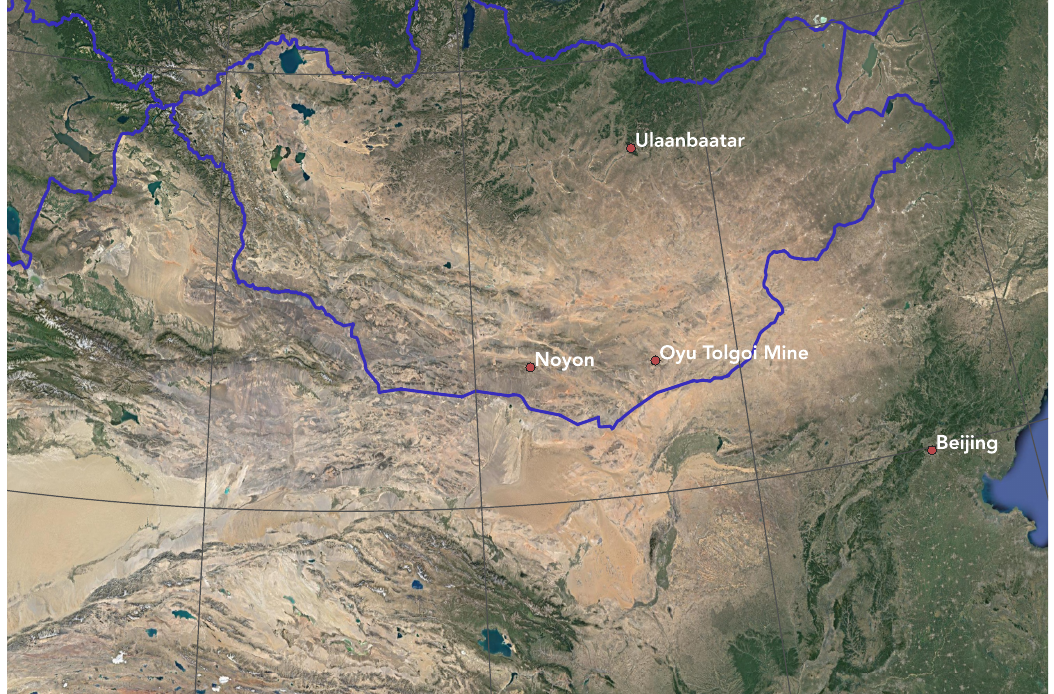
Figure 1. The Gobi Desert, with Noyon and Oyu Tolgoi. Imagery: Landsat/Copernicus; Data SIO; NOAA; US Navy; NGA; GEBCO (2018). Data: Google